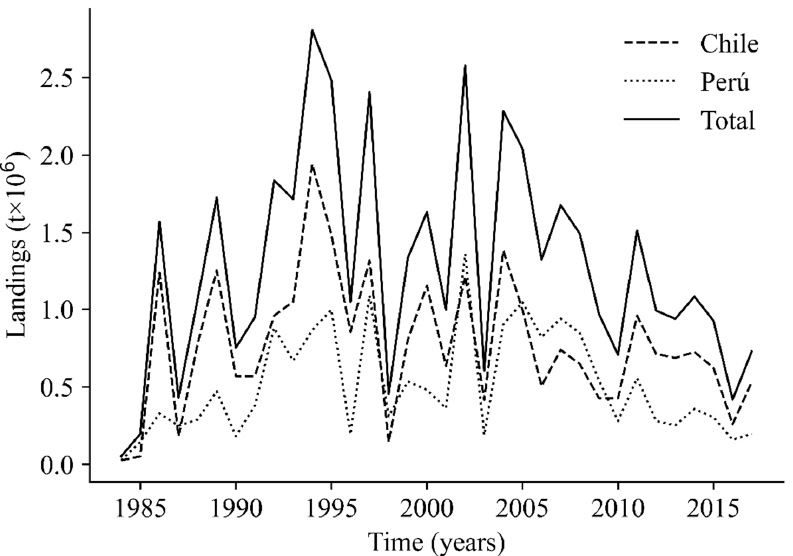
Figure 2. Annual landings of the industrial fleet that operates over the anchovy stock shared by Southern Peru and Northern Chile. Data were obtained from [3].